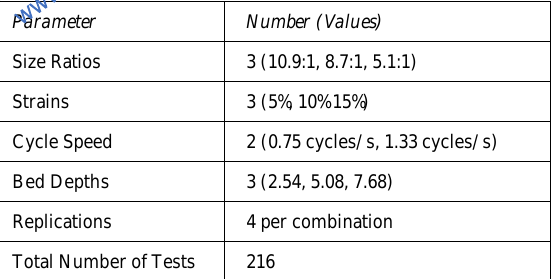
Table 2 Testing schedule for size-segregation analysis of binary mixtures